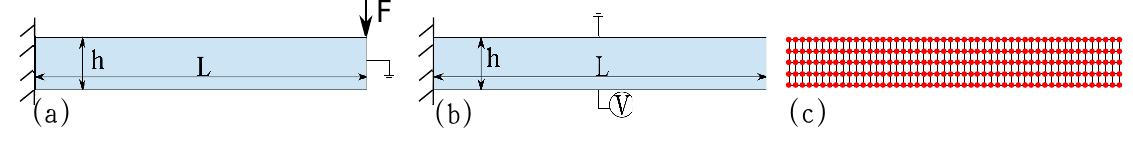
Figure 2. Schematic illustration of the cantilever beam under ( a ) mechanical loading and ( b ) electrical loading. ( c ) MLS discretization with the red solid point representing the